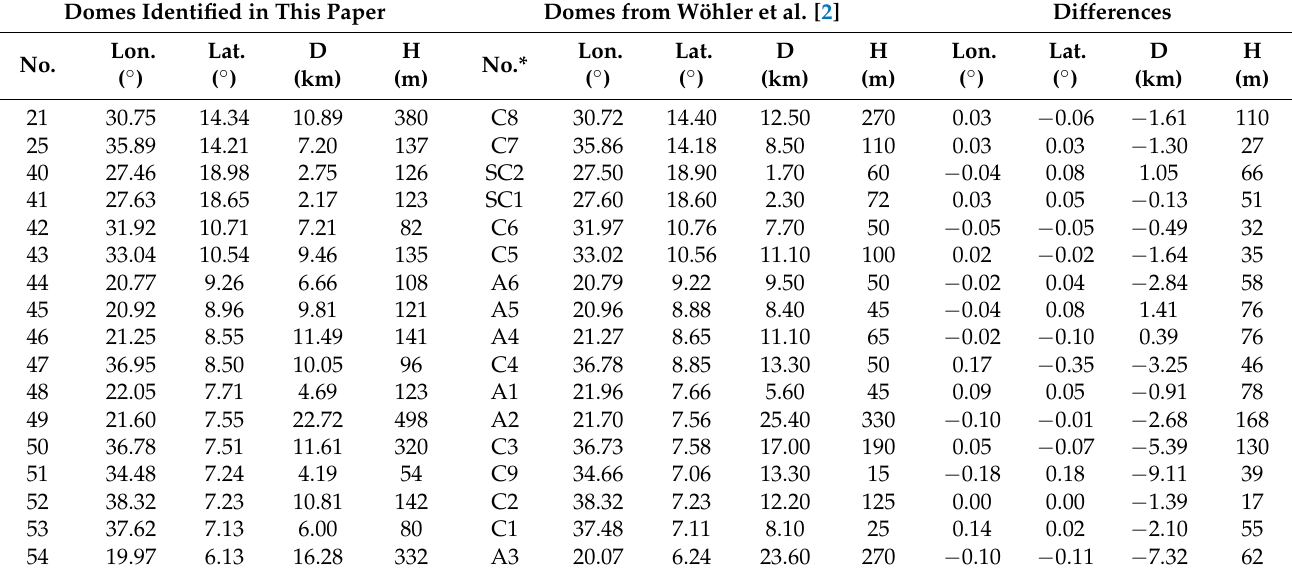
Figure A2. Graphs showing the variation of ( a ) FeO vs. TiO 2 , ( b ) diameter vs. TiO 2 , ( c ) area vs. TiO 2 , ( d ) surface volume vs. TiO 2 , ( e ) average flank slope vs. TiO 2 , ( f ) plastic viscosity vs. TiO 2 , ( g ) effusion rate vs. TiO 2 , and ( h ) duration vs. TiO 2 of 54 domes in both the Gardner volcano and mare Tranquillitatis. Table A1. Morphometrical comparison of domes with corresponding